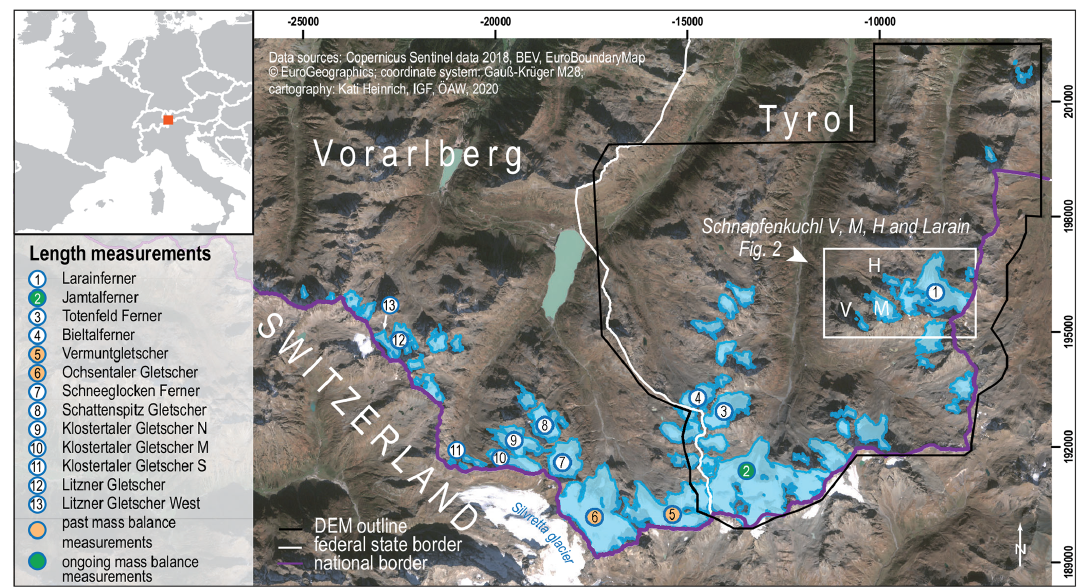
Figure 1. Overview of the glaciers and ongoing and past mass balance and fluctuation time series in the Austrian part of the Silvretta range. The DEM of the Tyrolean part dates from 2018 (black outline) and of Vorarlberg from 2017.